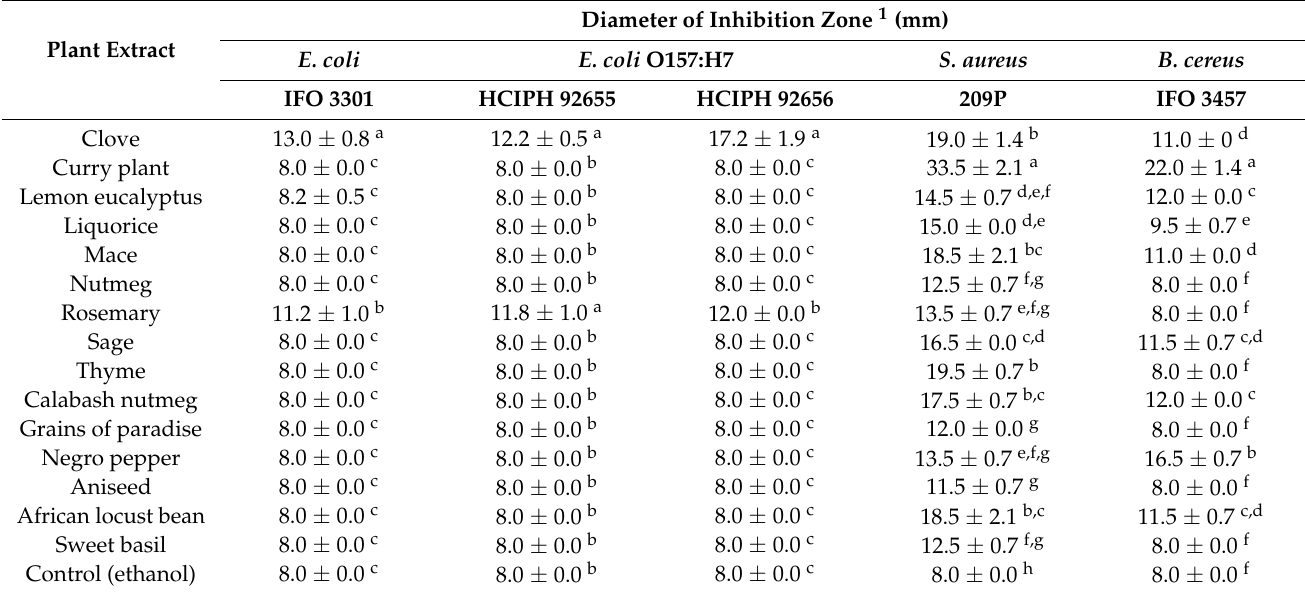
Table 3. Antibacterial activity of ethanolic plant extracts by disk-diffusion method against E. coli.